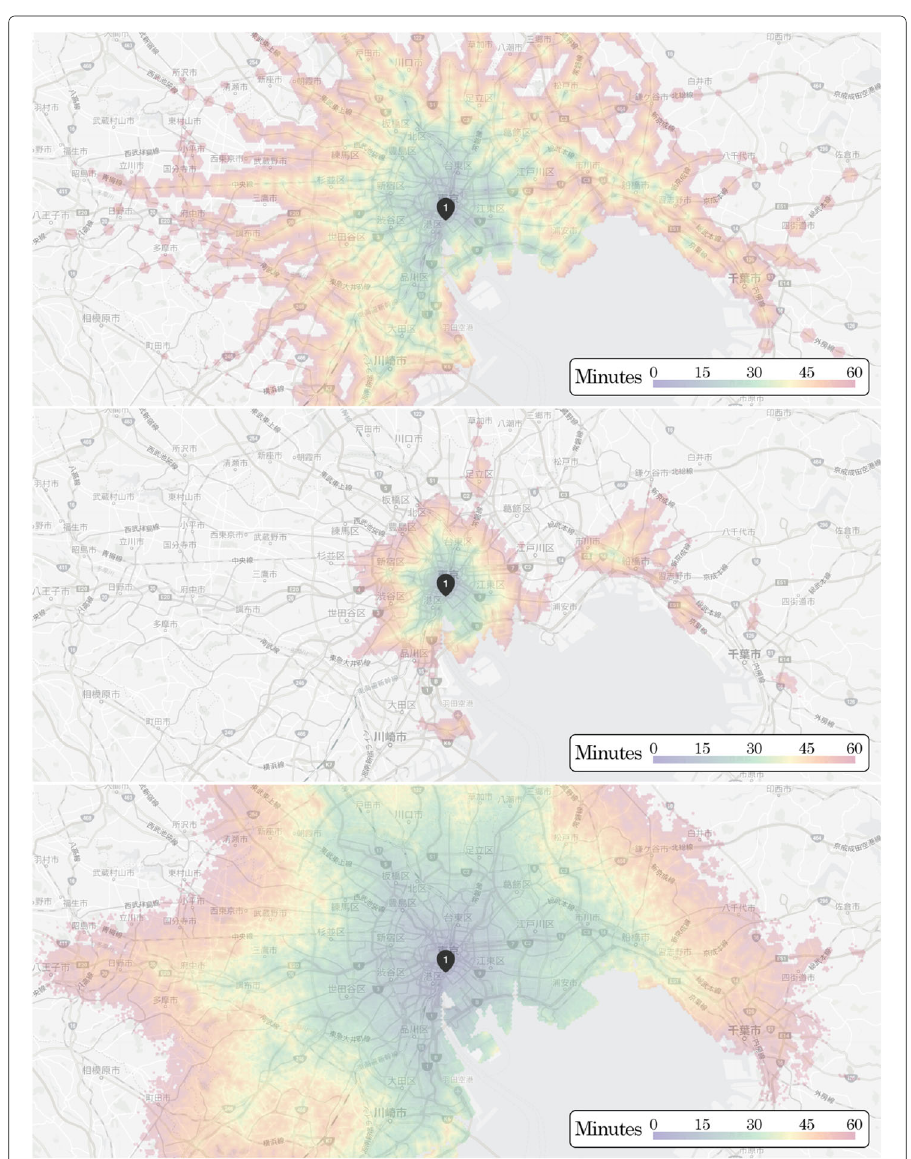
Fig. 5 Figure demonstrating the total travel time using rail (top), bus (middle), and driving (bottom) from the hex including Tokyo station to each hex reachable within 60 min. Zoomed in to show detail. Map data ©2019